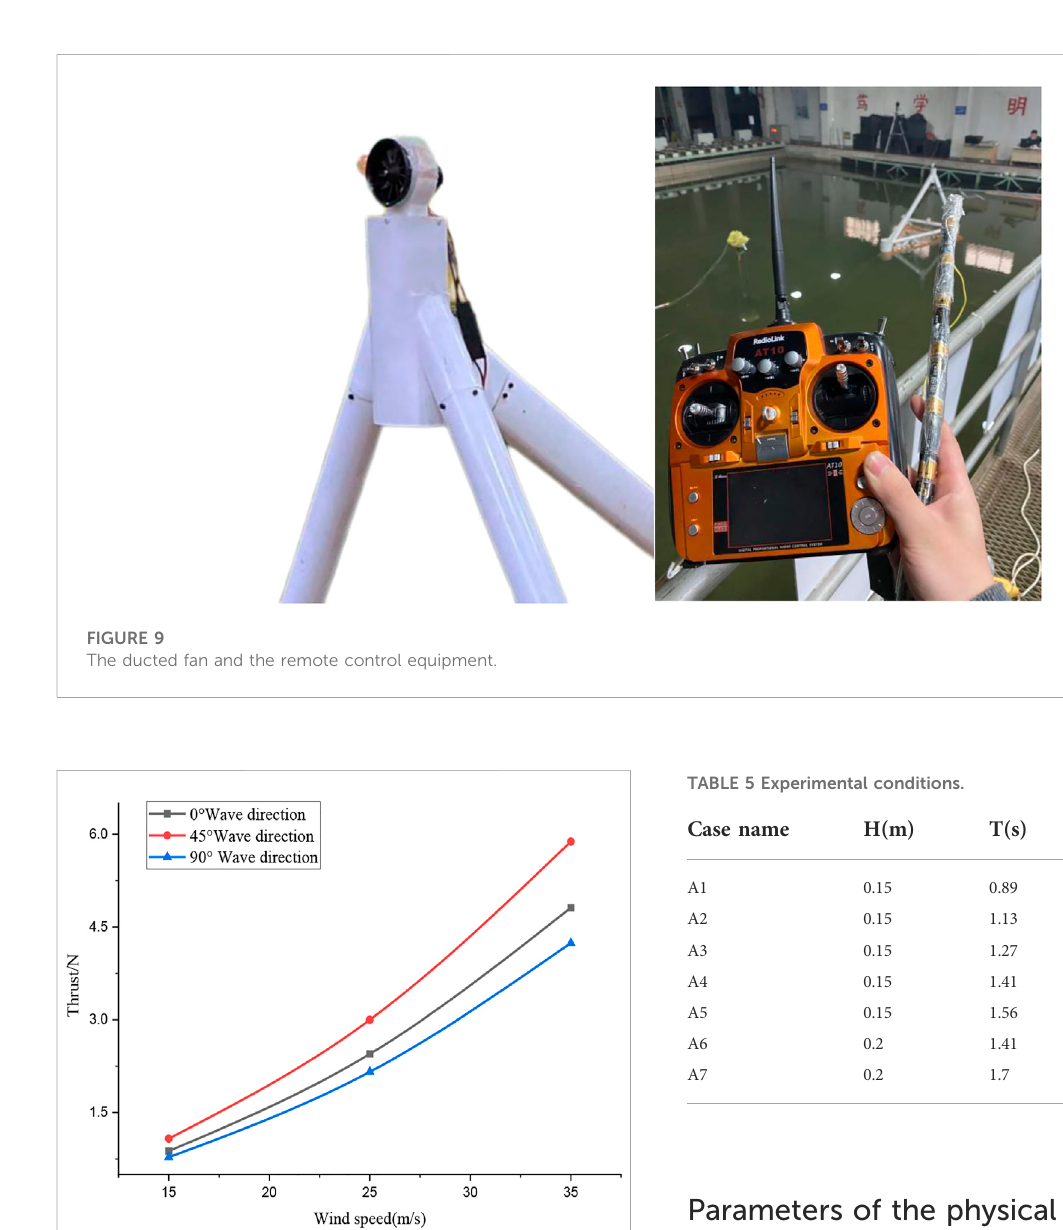
FIGURE 10 The wind speed — thrust curve.